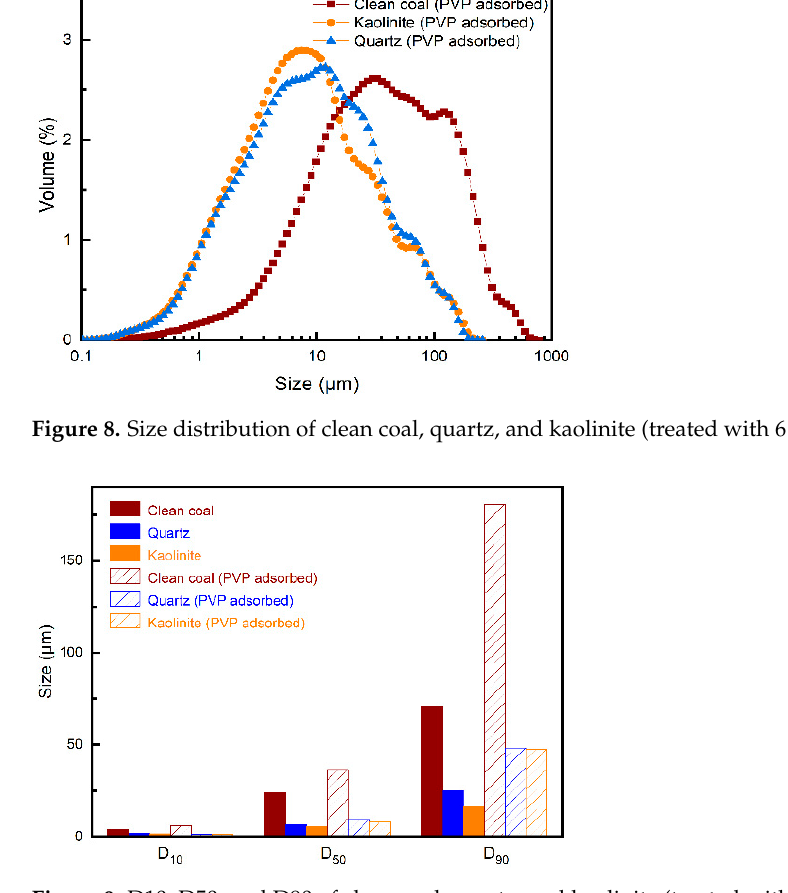
Figure 9. D10, D50, and D90 of clean coal, quartz, and kaolinite (treated with 6 mg/L PVP).